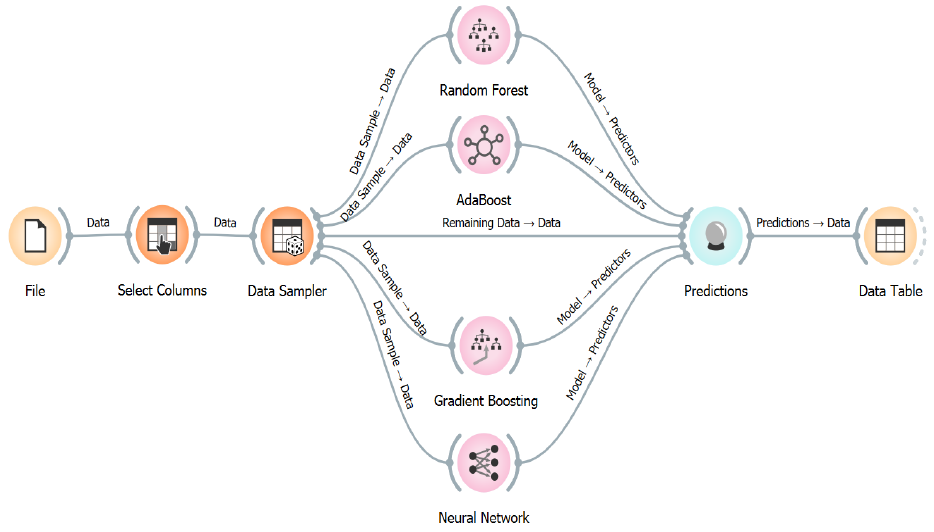
Figure 3. The software screenshot of AB, RF, NN, and GB models based on the ML.